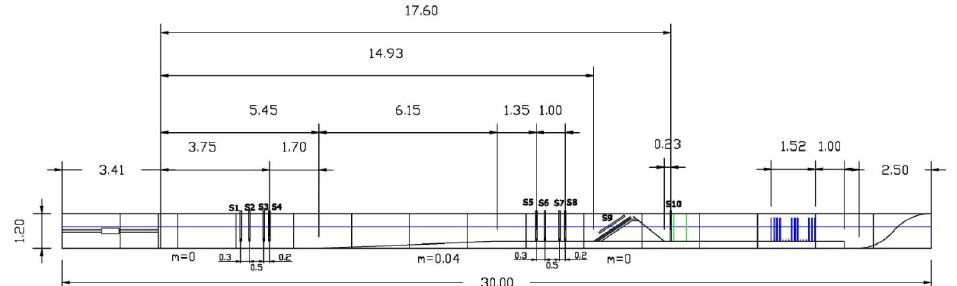
Figure 1. Longitudinal cross-section of the Laboratory of Ports and Coasts at the Universitat Politècnica de València (LPC-UPV) wave flume (dimensions in meters).